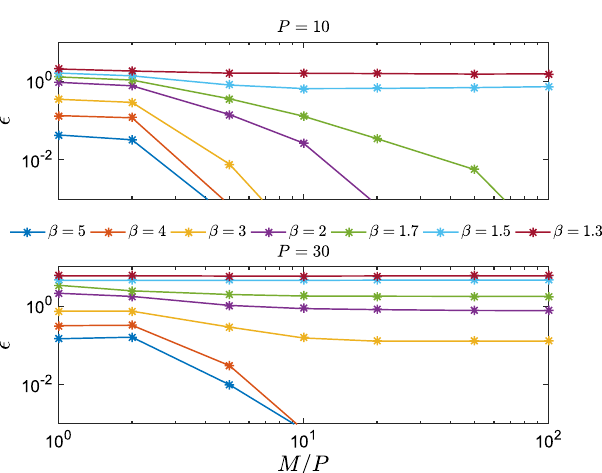
1000 with a number of patterns P 10 = = 2 P students. The error is ′ =